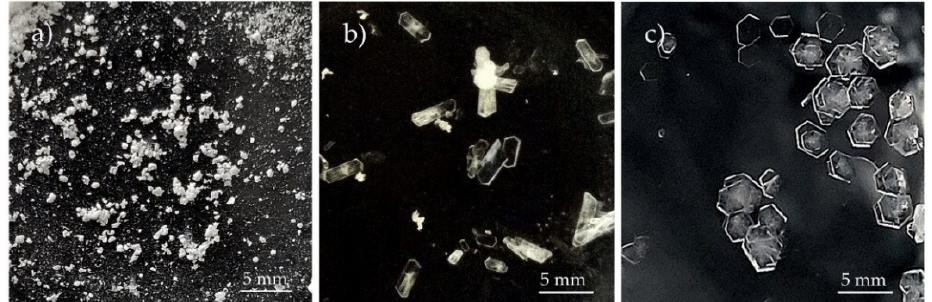
Figure 4. Crystal packing of saccharin salt of chlordiazepoxide viewed along the a-axis (hydrogen bonds are represented by dashed lines). Table 4. C–X··· π interaction geometry for saccharin salt of chlordiazepoxide.